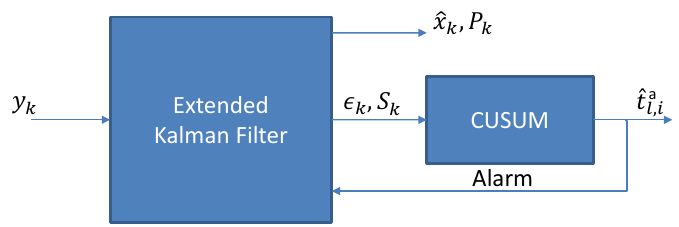
Figure 5. Architecture of the change point detector.